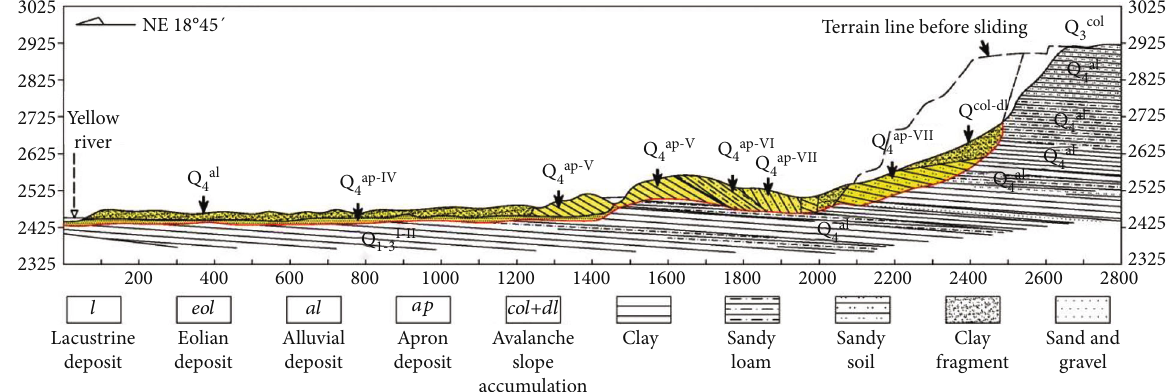
Figure 3: Geological pro fi le of Chana landslide